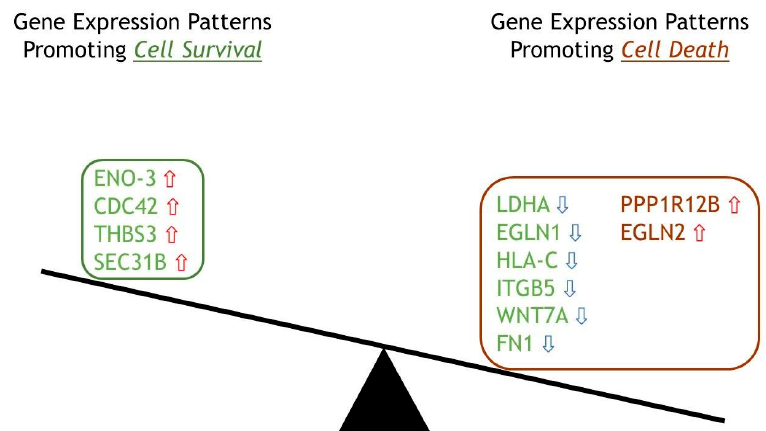
Figure 5. A balance diagram depicting significant differentially expressed genes classified into their role in the ERAP2N-positive trophoblast cell fate. Balance diagram of 12 significant differentially expressed genes divided into favoring either a cell survival or cell death role in the setting of ERAP2N. Green represents expression patterns favoring cell survival, and maroon represents expression patterns favoring cell death. Red arrows indicate that the gene was up-regulated, and blue arrows indicate that the gene was down-regulated in the setting of ERAP2N.